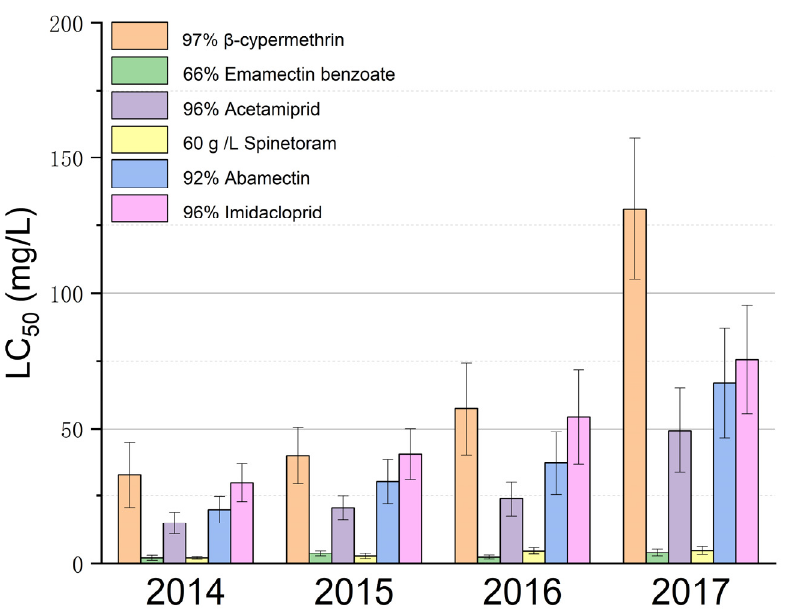
Figure A1. Virulence trend chart of six insecticides used against the Haikou field population of M. usitatus in Hainan Province. The data adapted with permission from Ref. [37]. 2015, Tang, L. D.; and Ref. [39]. 2018, Tang, L. D. The number of each concentration gradient repeat is 4.